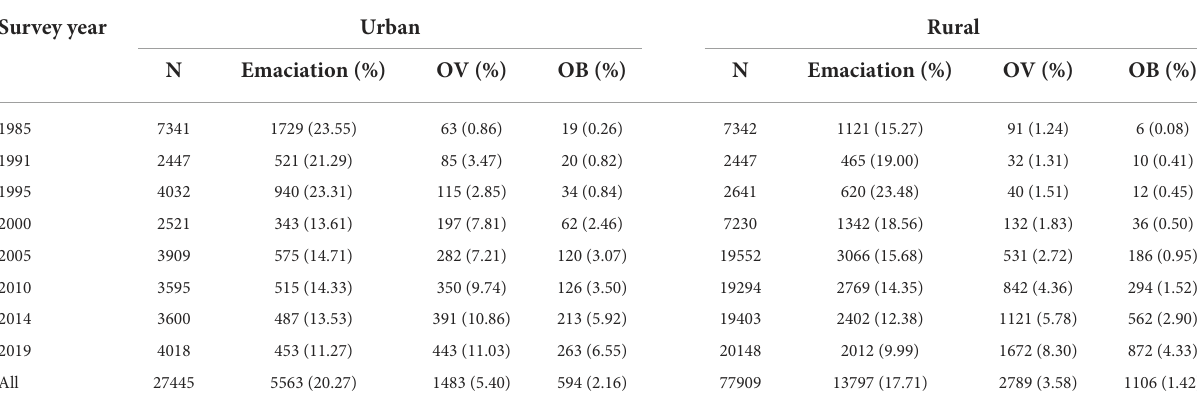
TABLE 3 The prevalence of overweight and obesity for urban and rural in Yunnan: 1985–2019. Survey year Urban Rural